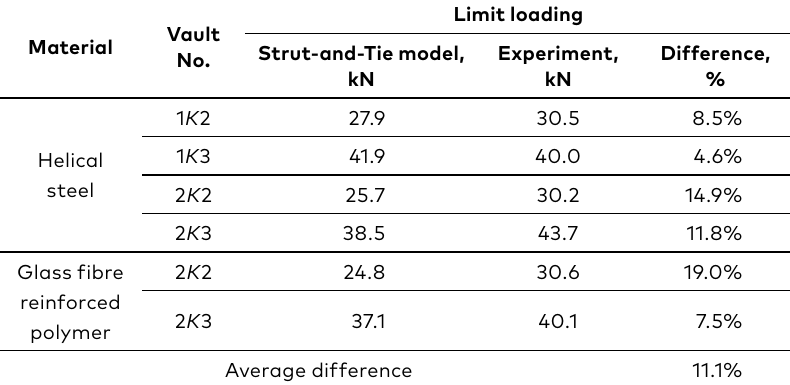
Table 1. Comparison of the Strut-and-Tie model to experiments − achieved calculated